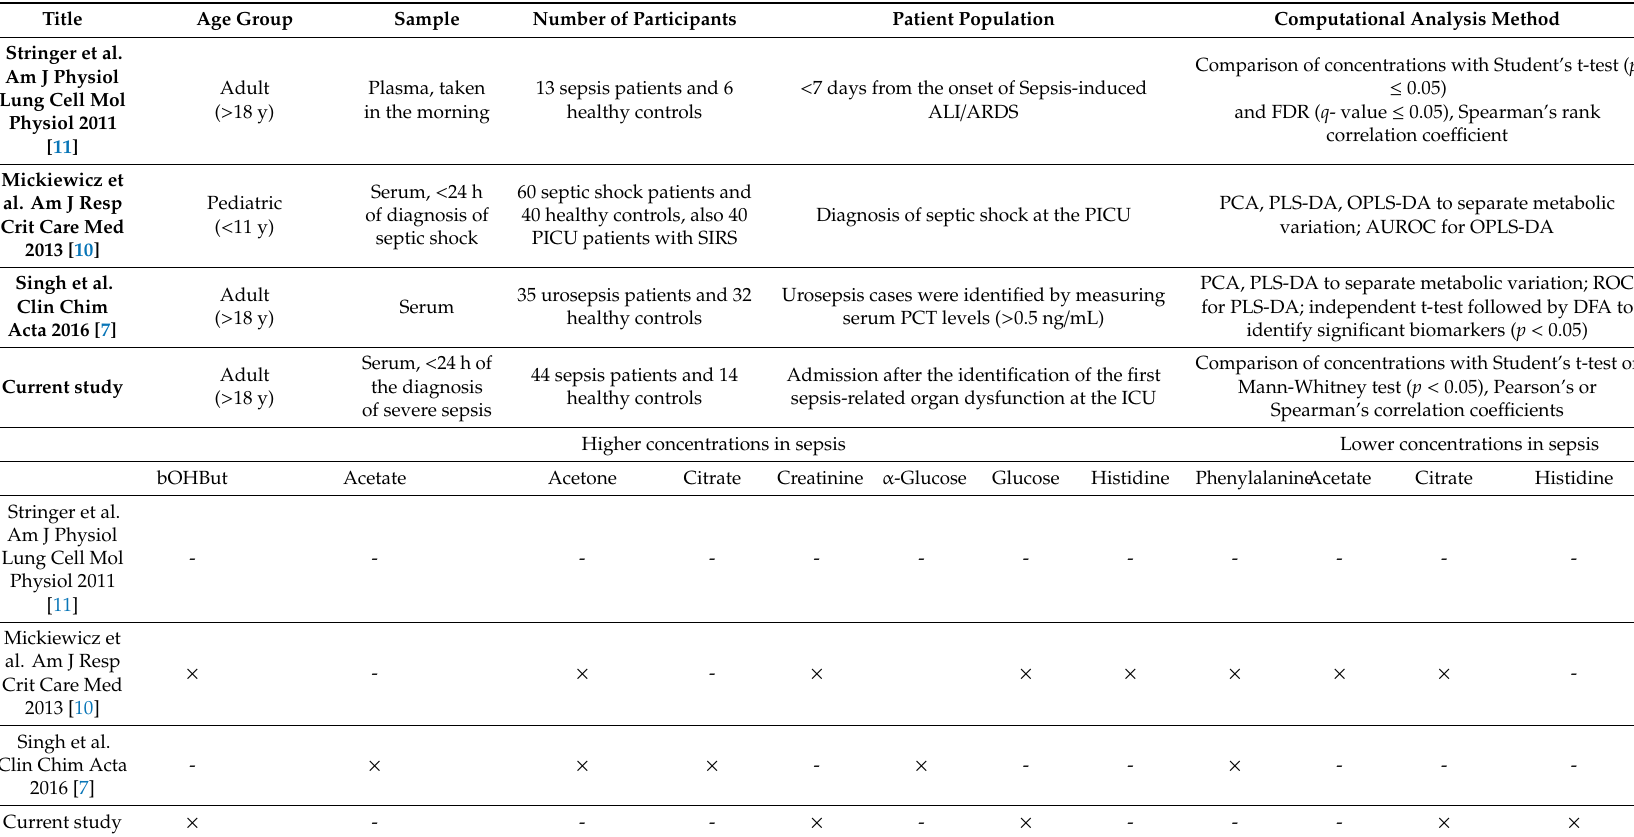
Table 5. Studies comparing blood samples between patients with sepsis and healthy controls analyzed with proton nuclear magnetic resonance (1H NMR) spectroscopy. The metabolites are categorized as concentrations higher or lower in sepsis compared to healthy controls. We chose metabolites that were statistically significant in two-samples t tests or in PCA / (O)PLS-DA / DFA models, and we show only those metabolites presented in more than one of the table studies. ALI = acute lung